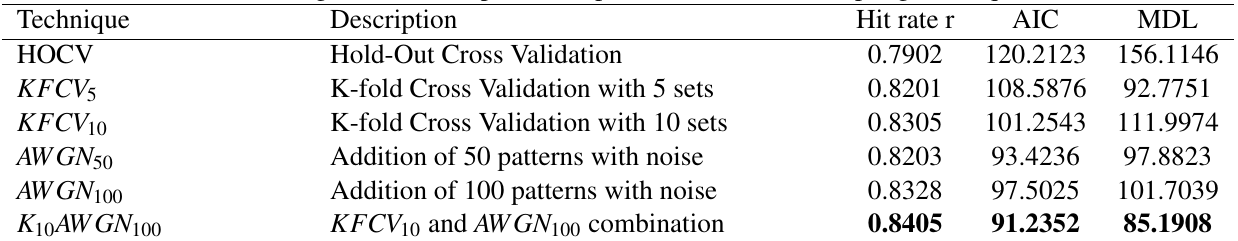
Figure 4: Stage 2. Evolution of the accuracy of the MLP related to the training set size Table 9: Stage 2. List of experiments performed with the sampling